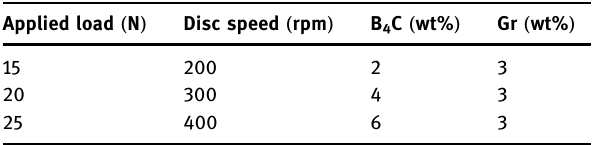
Table 2: Wear test parameters and levels Applied load ( N )